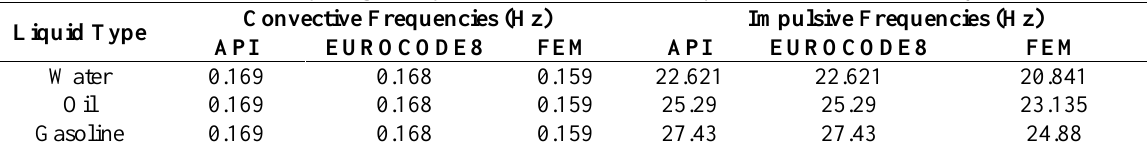
Impulsive Convective